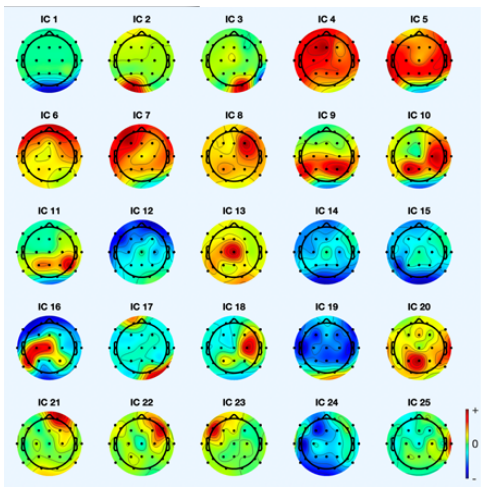
Figure 4. Topoplots of the independent components.